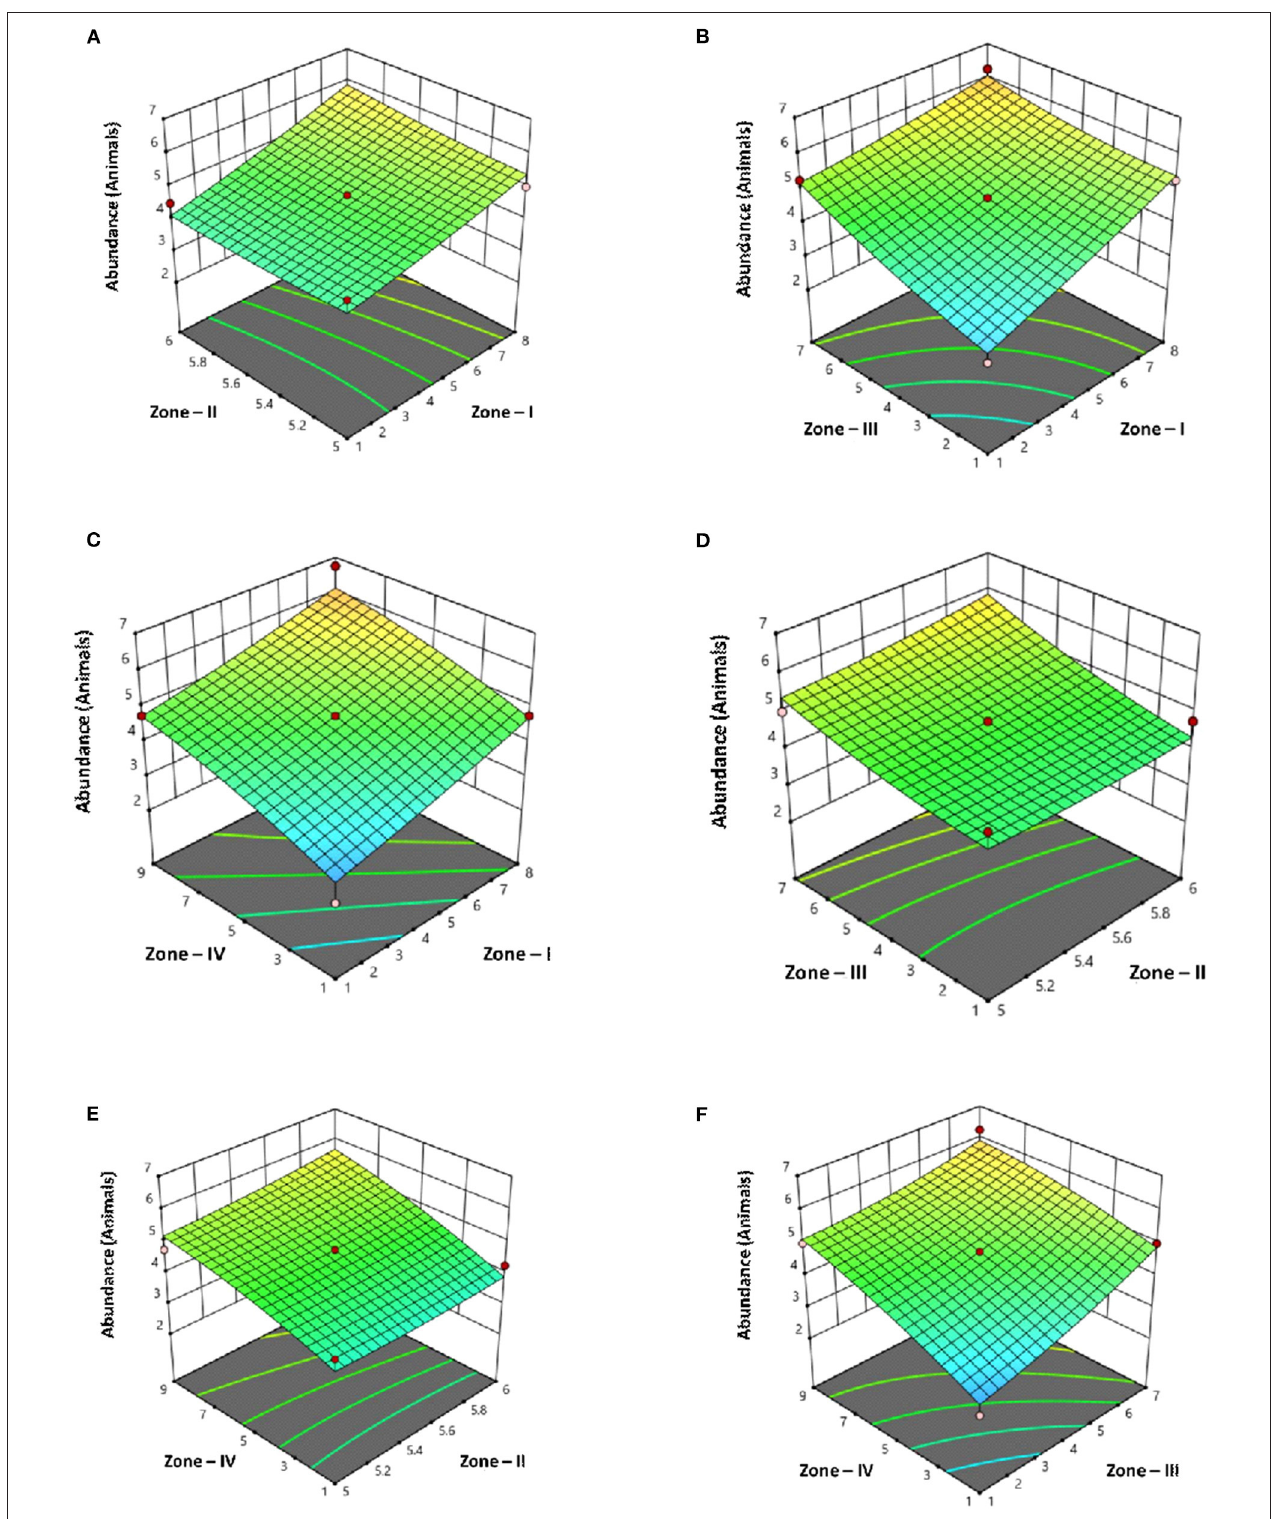
FIGURE 4 | Surface plots of C. perfringens toxins in four different zones with Punjab province in Pakistan with their interaction (A) Zone–I × Zone–II (B) Zone–I × Zone–III (C) Zone–I × Zone–IV (D) Zone–II × Zone–III (E) Zone–II × Zone–IV (F) Zone–III × Zone–IV.